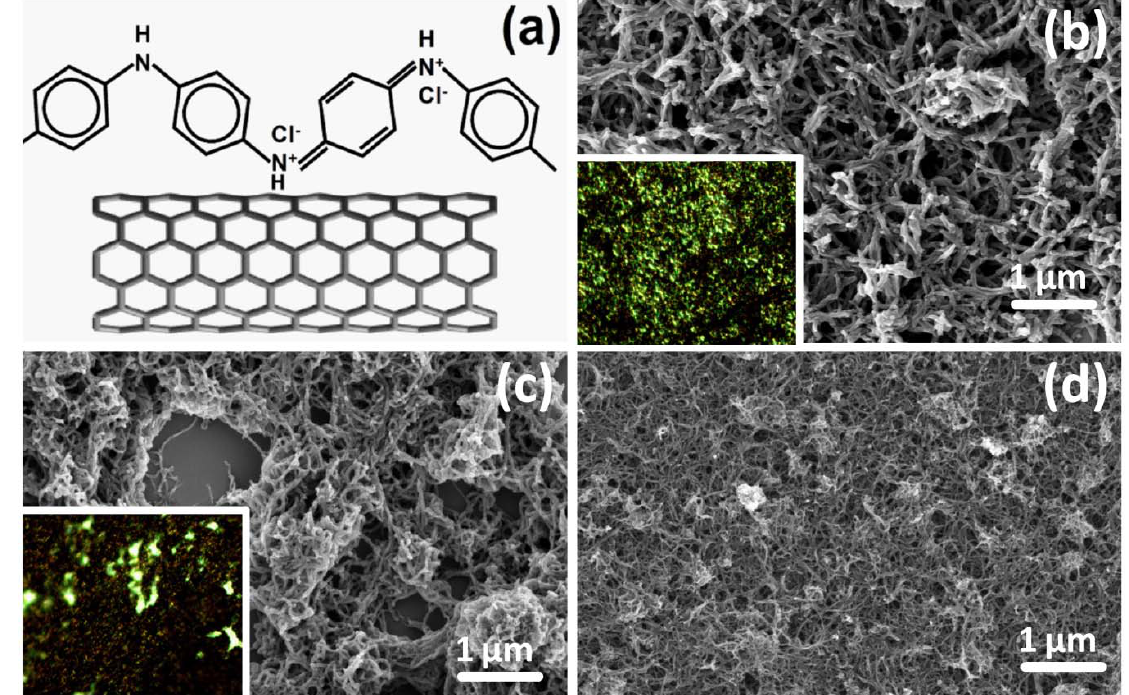
Figure 1. ( a ) Schematic structure of polyaniline in emeraldine base (PANI-ES) and outer-shell of multi-walled carbon nanotube (MWCNT) and high-resolution scanning electron microscopy (HRSEM) image of ( b ) nanofibrillar ( nf-) PANI; ( c ) nf-PANI/MWCNT-20wt% and ( d ) nf-PANI/MWCNT-50wt%. The insets are the optical microscopy images of the films (nf-PANI (b) and nf-PANI/MWCNT-20% (c)) with 200 × 160 μ